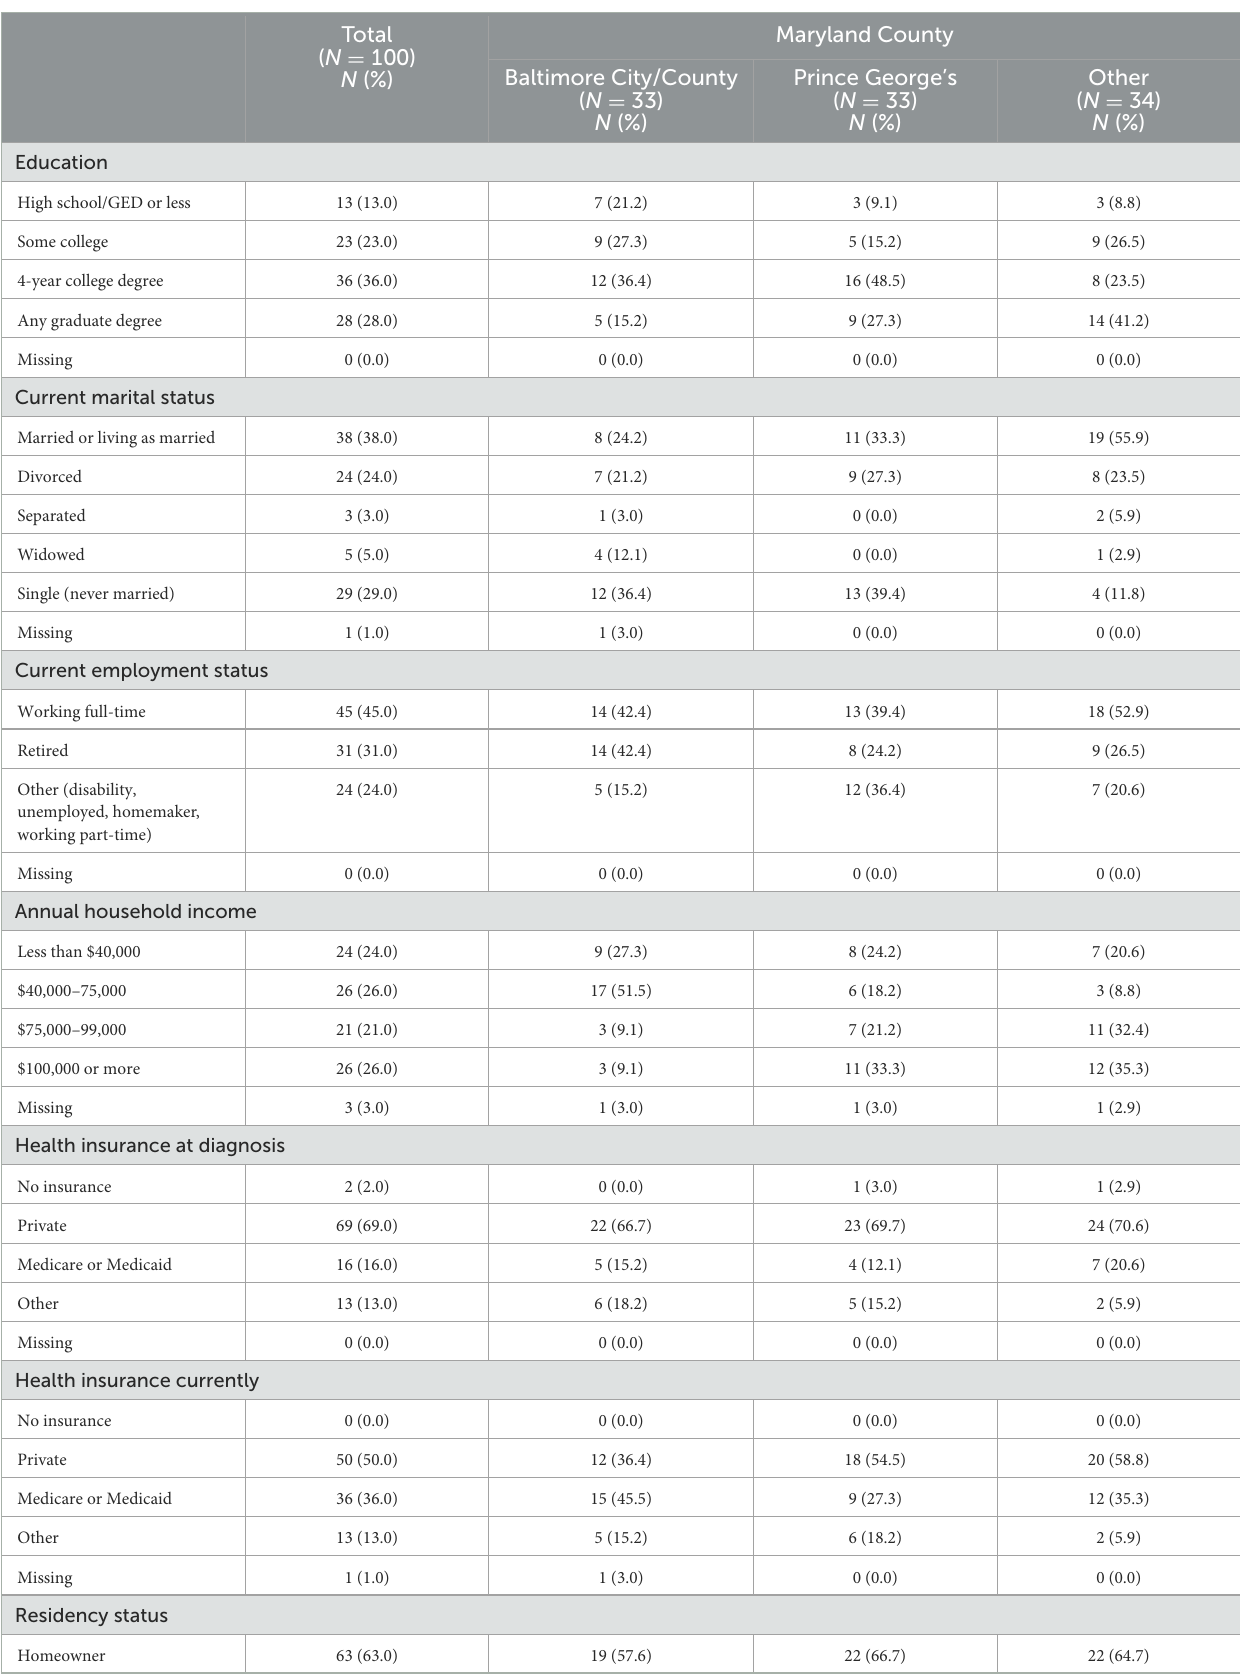
TABLE 1 Demographic characteristics of study population overall and stratified by Maryland county ( N =